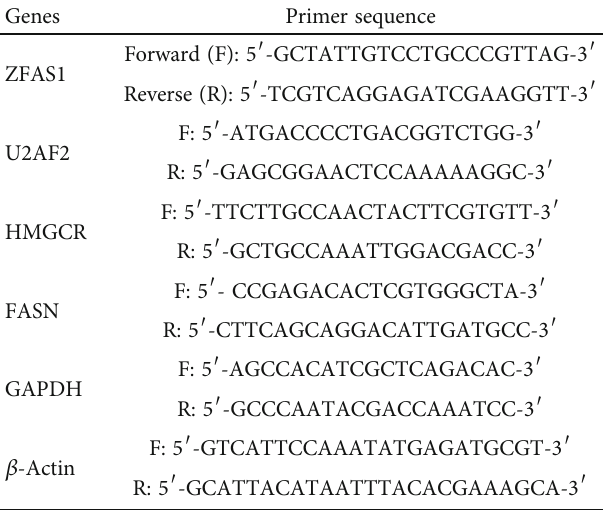
Table 1: Primer sequences utilized in this study.